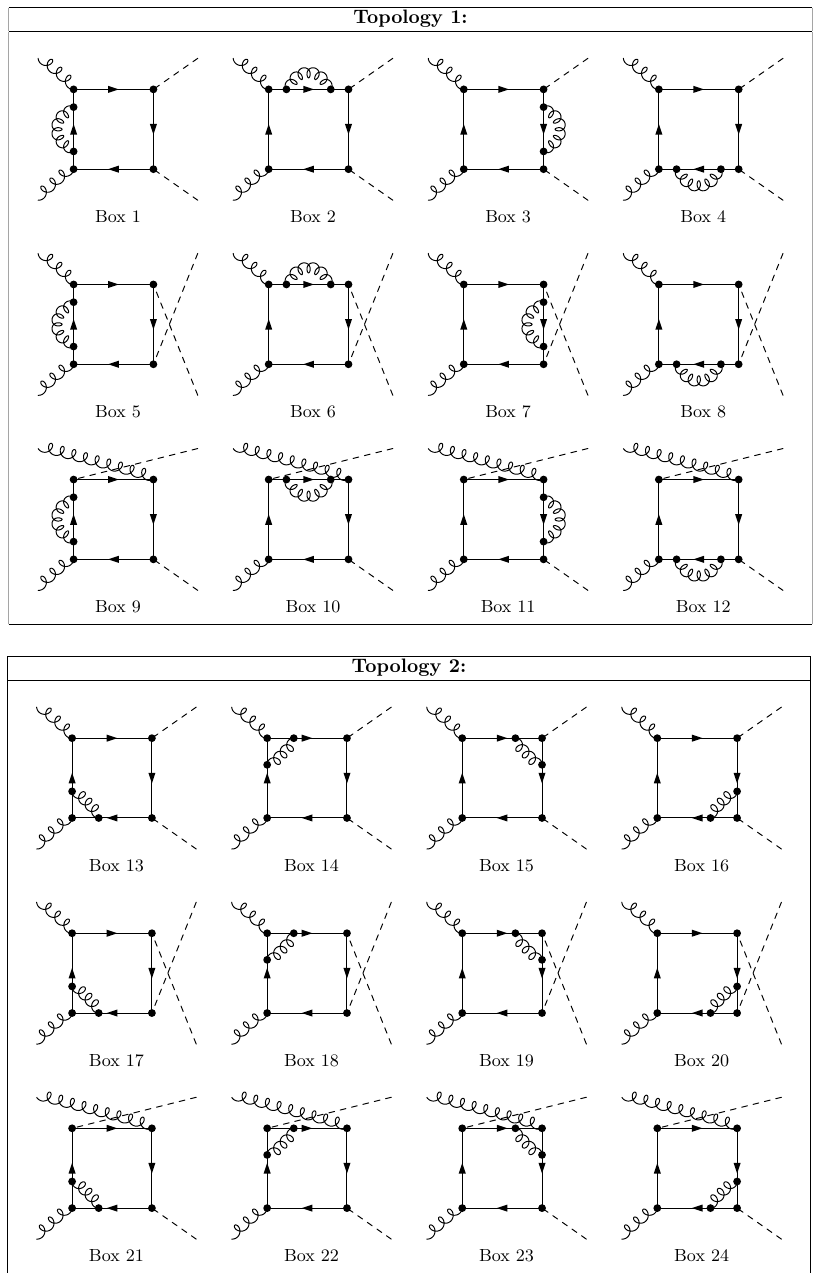
Figure 19 . Two-loop box diagrams: topologies 1 and 2.